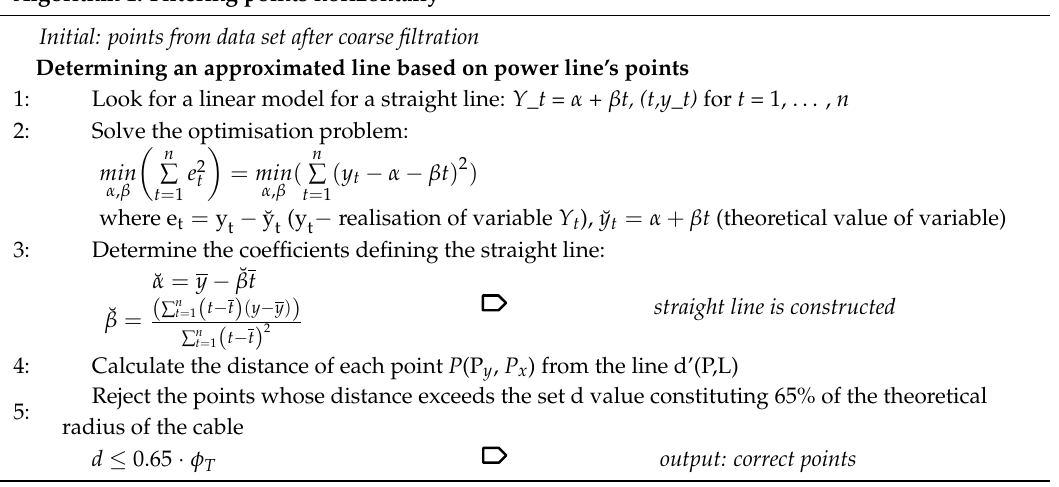
Algorithm 1. Filtering points horizontally